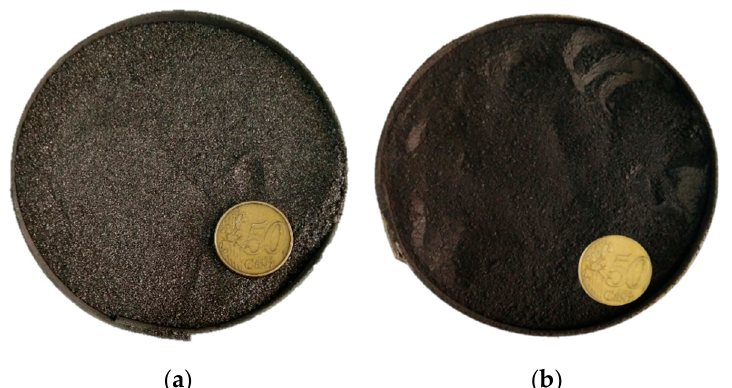
Figure 2. Texture of the sandblasting metal by-products used in the experimental mixtures according to their extraction process: ( a ) sieving; ( b ) sieving and aspiration.